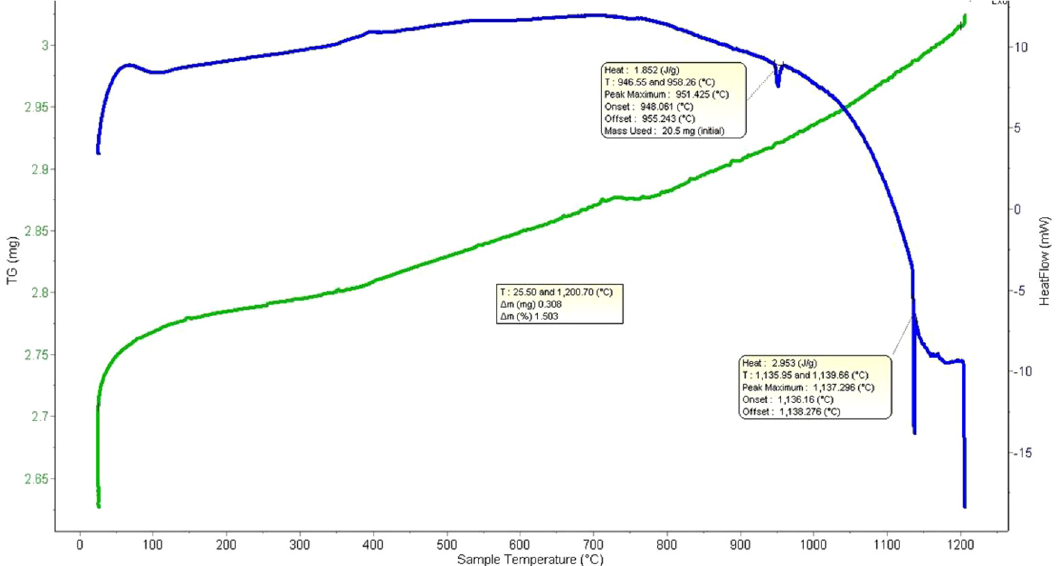
Fig. 6. DSC-TG analysis of cold-sprayed Ni-20% Sn nanostructured